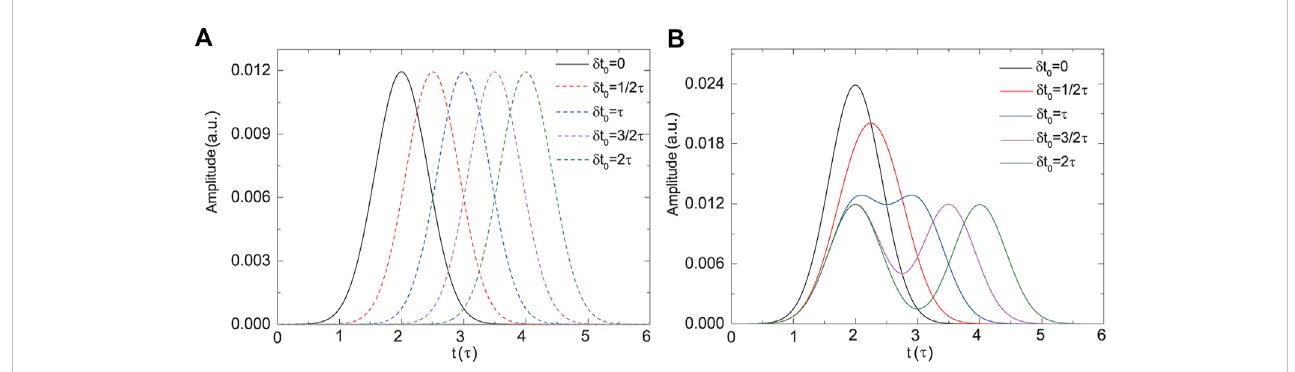
FIGURE 1 (A) The envelope functions of the two laser pulses at fi ve different delay times, δ t 0 = 0, 1/2 τ , τ , 3/2 τ and 2 τ , respectively. The solid and dashed curves denote f 1 ( t ) and f 2 ( t ), respectively. (B) The total envelope function of the two laser pulses according to the fi ve different delay times. Here, τ = 100